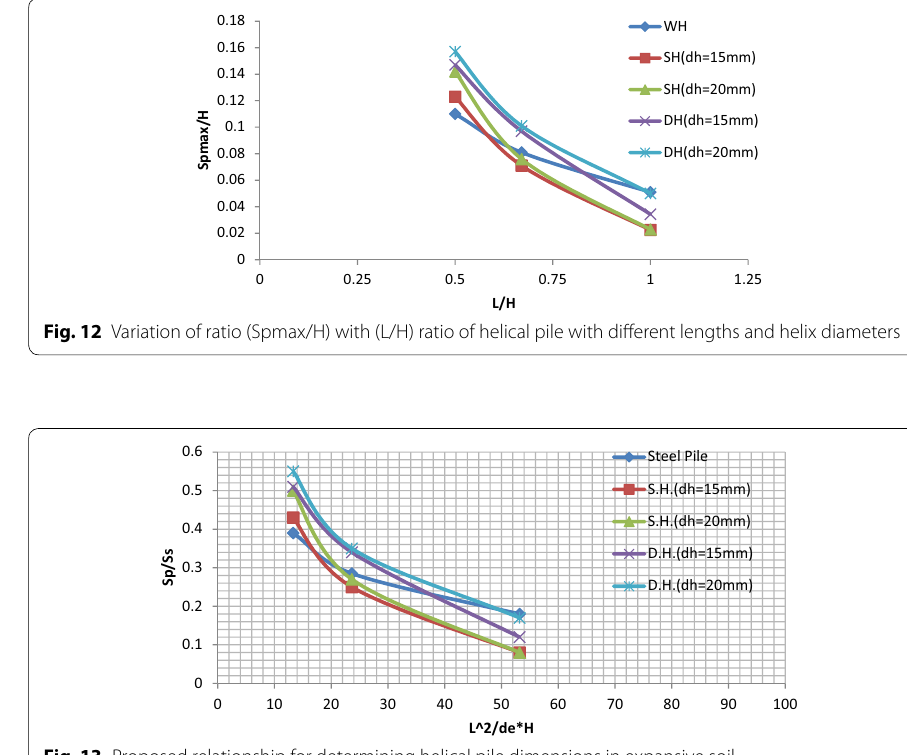
Fig. 13 Proposed relationship for determining helical pile dimensions in expansive